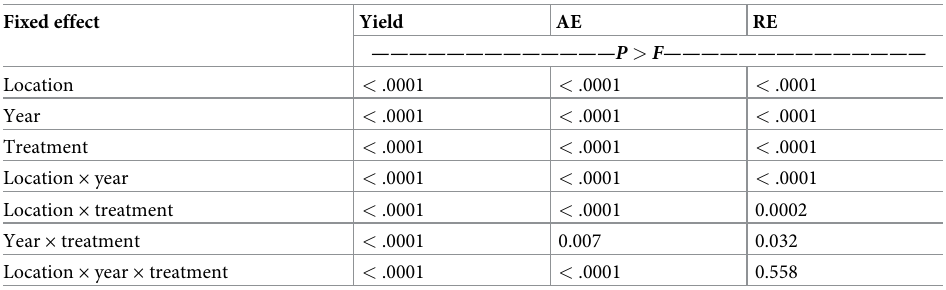
Table 2. Tests of fixed effects on maize grain yield, agronomic efficiency (AE), and recovery efficiency